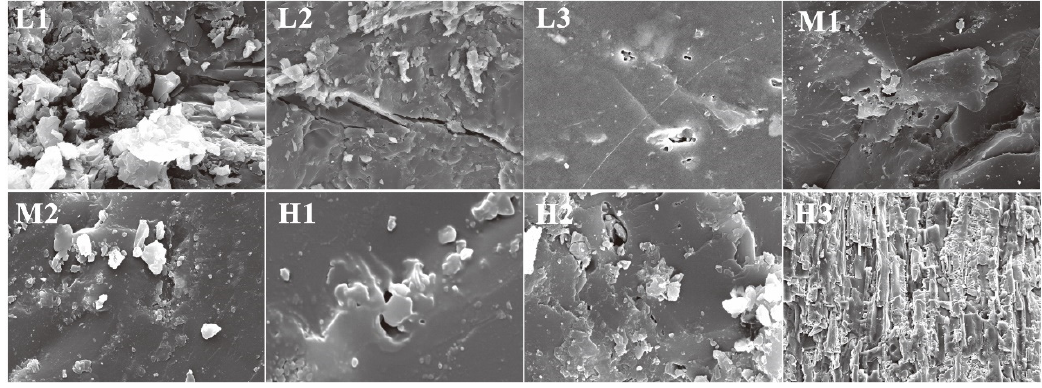
Table 1. Detailed information of the selected coals.